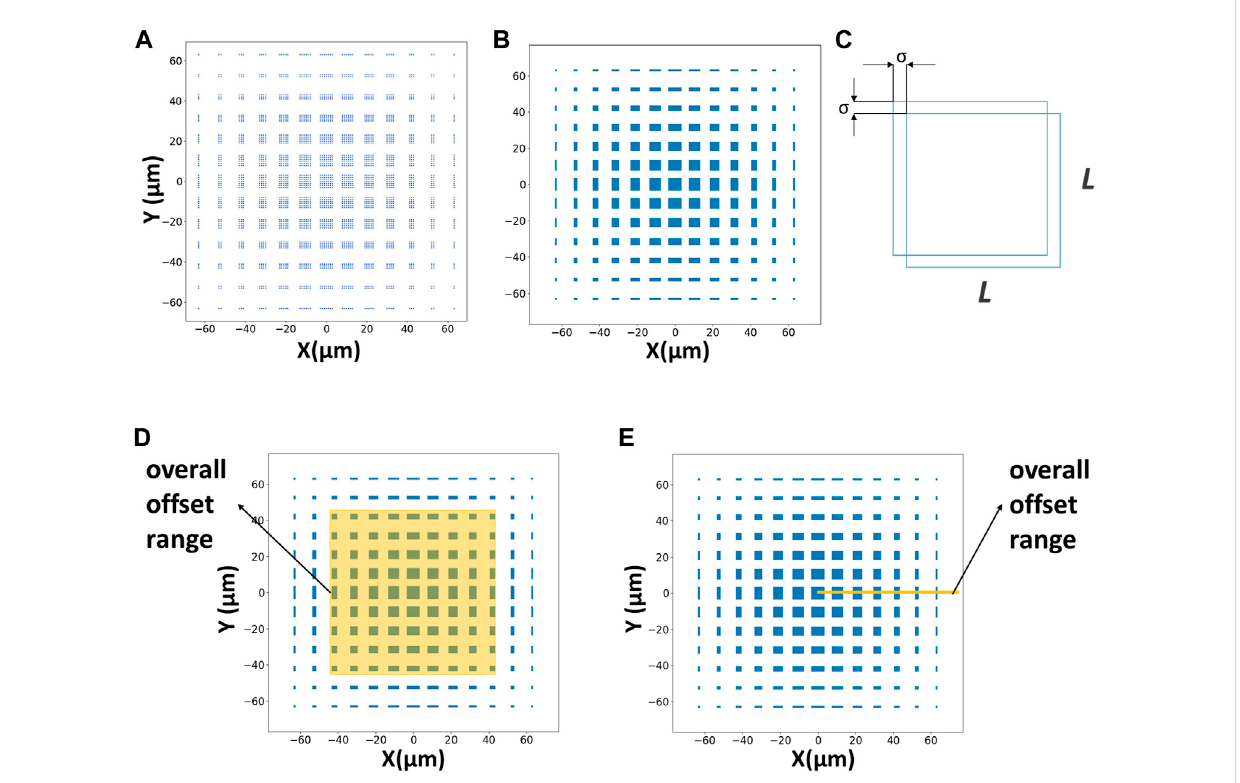
FIGURE 2 Measurements of alignment offsets. (A) The blue area represents the offset of the matrix when there is a pair of totally aligned micropatterns (N = 7 μ m, L = 5 μ m, d = 5 μ m, Δ d = 1 µm). (B) The blue area represents the offset of the matrix when there is a pair of aligned micropatterns with 0.5 µm alignmentaccuracy(N=7 μ m,L=5 μ m,d=5 μ m, Δ d=1 μ m, σ =0.5 µm). (C) Thealignmentaccuracymeasurement.Inordertofacilitatethecalculation, only consider the XY offset, and both the accuracy are set to σ . (D) Schematic diagram of the area method. (E) Schematic diagram of the length